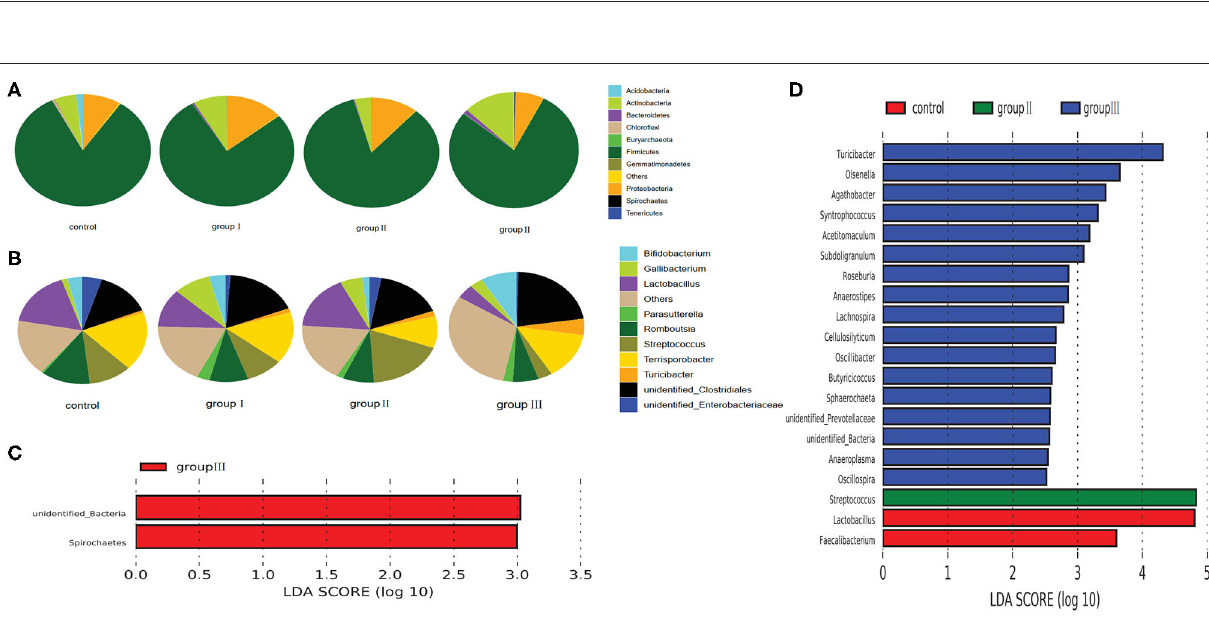
Frontiers in Nutrition |